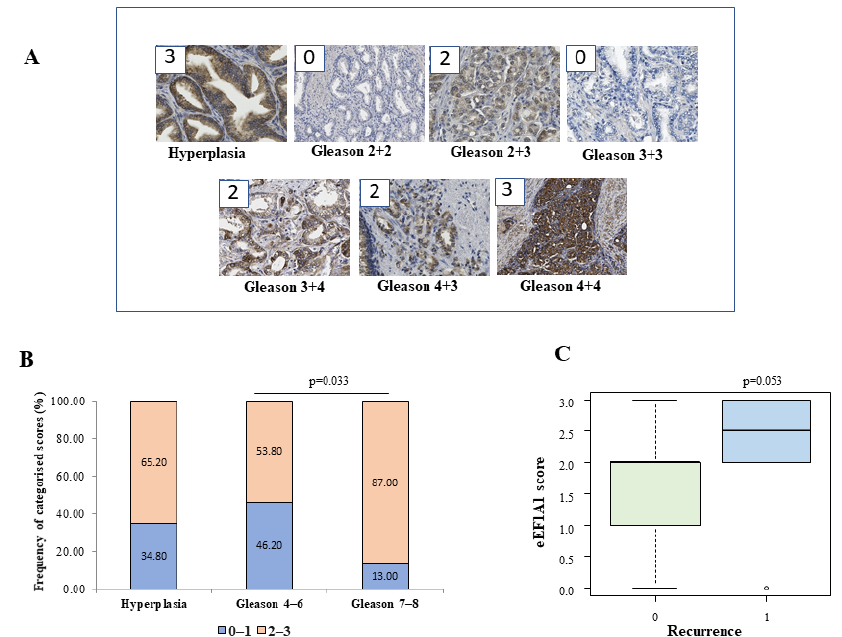
Figure 1. Immunohistochemistry of eEF1A1 expression in tissues. The sample tissues of a cohort of patients were analysed retrospectively, as described in the Materials and Methods. ( A ) Representative images of 20× magnification samples and assigned scores (in boxes). ( B ) Distribution of eEF1A1 protein scores in the groups under study (Hyperplasia n = 23; Gleason 4–6, n = 26; Gleason 7–8, n = 23). ( C ) Boxplot of the distribution of eEF1A1 score with respect to recurrence (1) and no recurrence (0) in cancer patients’ groups ( n = 44). The p values of the Mann–Whitney test for continuous variable or chi ‐ squared test for categorized values are shown.